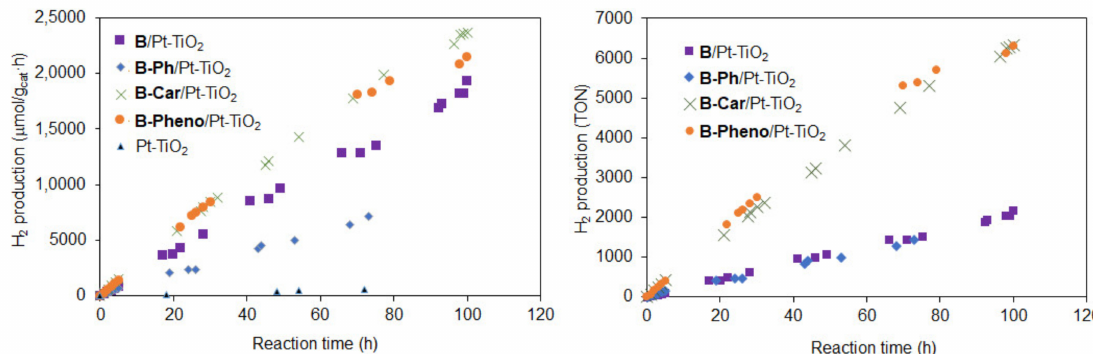
Figure 6. Photocatalytic hydrogen production results of B, B-Ph , B-Car , and B-Pheno / Pt-TiO 2 in water medium. ( Left ) Hydrogen production rate vs reaction time plot. ( Right ) Turn over number of hydrogen production from dye-sensitizer B, B-Ph , B-Car , and B-Pheno vs. reaction time plot. Conditions: Xe lamp (0.15 mW / cm 2 after filtered with long path filter of > 420 nm), 0.57 M ascorbic acid aq. (pH = 4.0).